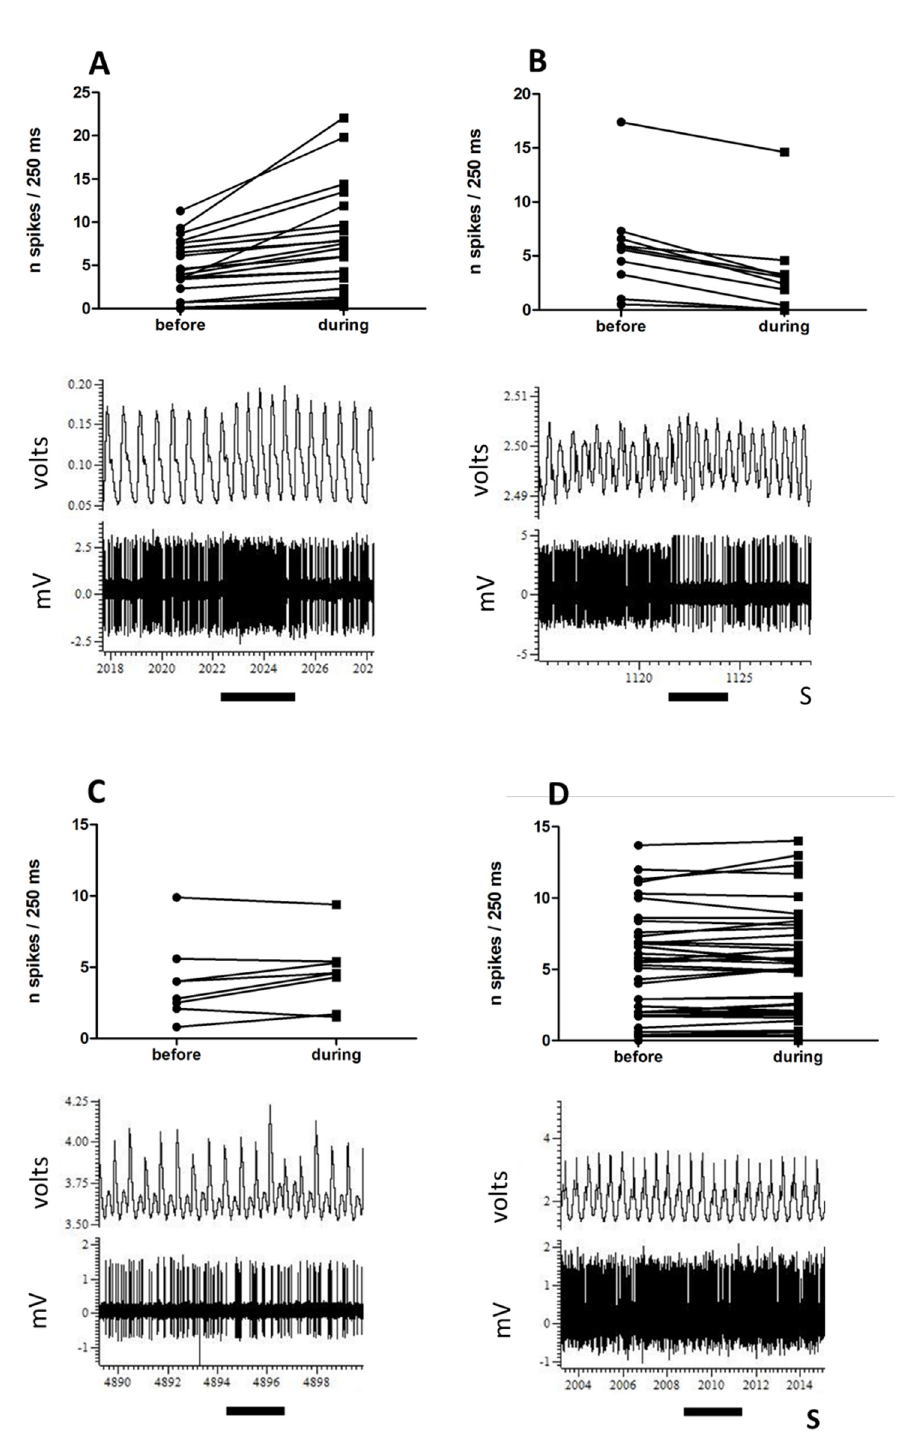
Figure 3. Four groups of neurones are distinguished from their response to food odour. From ( A ) to ( D ) top: all neurone activity before ( left ) and during ( right ) food odour stimulation. Activity is measured as number of spikes per 250 ms and averaged over 2 s before and 2 s during odour stimulation. Bottom: illustration of the response of a single neurone from the same group. Black bar, odour stimulation. Top trace is respiration, bottom trace is single unit recording. X axis in seconds (S). ( A ): 23 neurones increased their activity during food odour stimulation. ( B ): 10 neurones decreased their activity upon food odour stimulation. ( C ): these 8 neurones did not display a change in their activity but became rhythmic in phase with the respiratory cycle during odour stimulation. ( D ): 53 neurones didn’t respond to food odour stimulation.